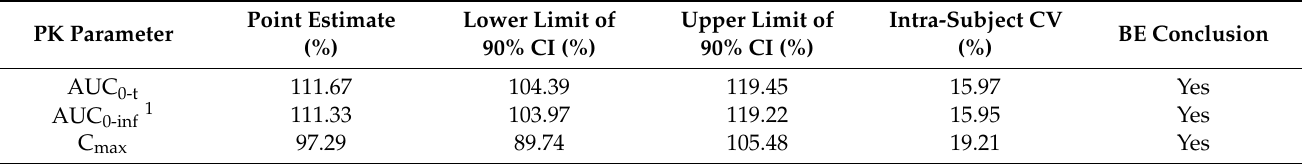
Table 1. Bioequivalence evaluation of desvenlafaxine 100 mg prolonged-release tablets after a single dose under fasting conditions in 32 healthy